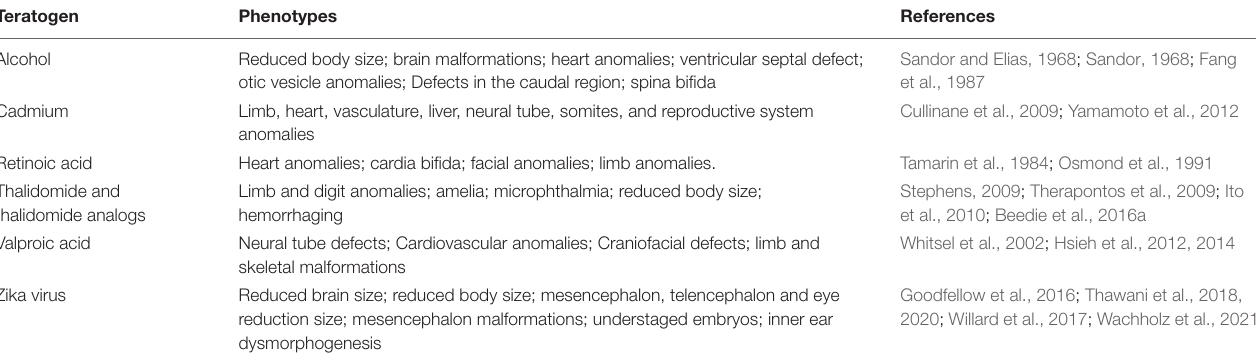
TABLE 1 | Morphological phenotypes observed after exposure of chicken embryos to teratogens.